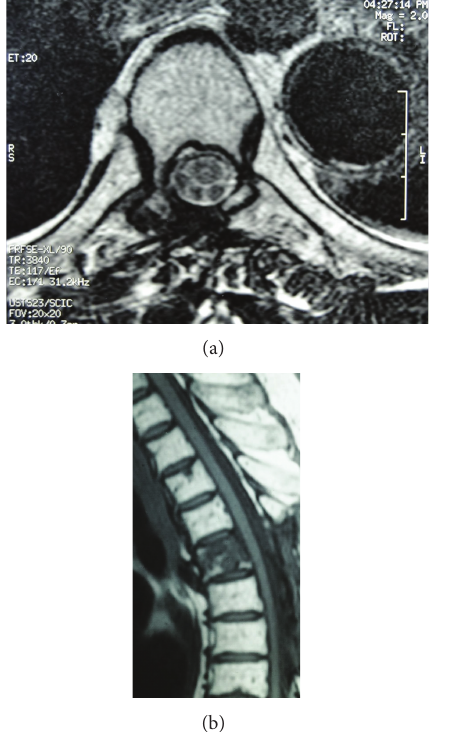
Figure 5: Postoperative axial (a) and sagittal (b) T1-weighted MR images showing extradural tumor removal and spinal cord decompression.